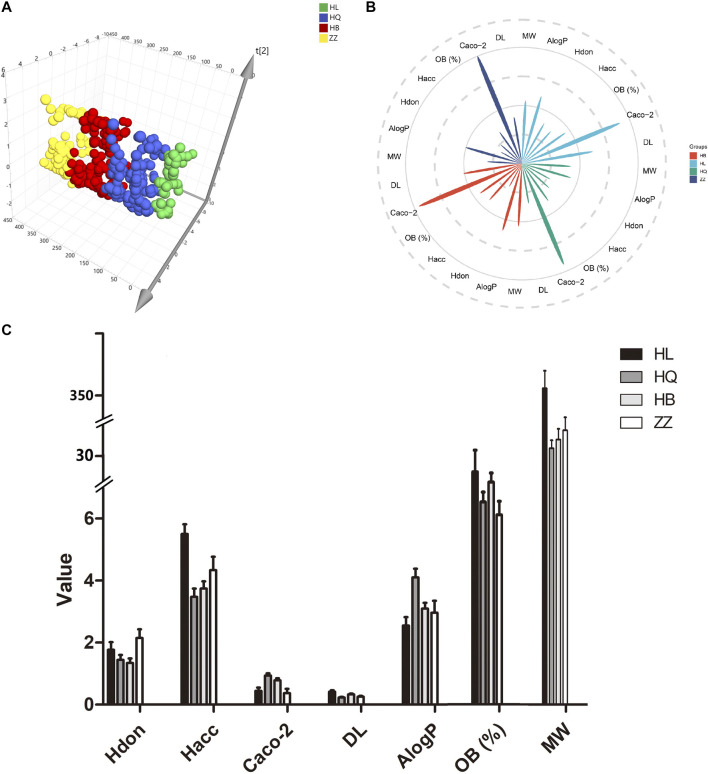
Analysis seven chemical properties of huanglian (HL), huangqin (HQ), huangbo (HB) and zhizi (ZZ) in HJD. A, B and C represent the chemical space, chemical distribution and the value of chemical parameters of all components visualized by PCA scores plot, polar coordinate petal diagram and bar chart, respectively.